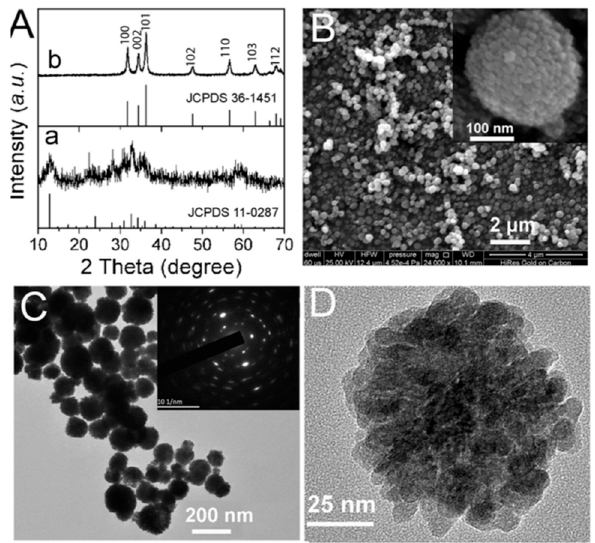
Figure 13. XRD analysis of ZHCH (a) and ZnO (b) ( A ) and SEM micrographs of ZnO showing agglomeration of small nanoparticles that compose nanospheres ( B – D ). Reprinted with permission from [60]. Copyright (2017) Elsevier